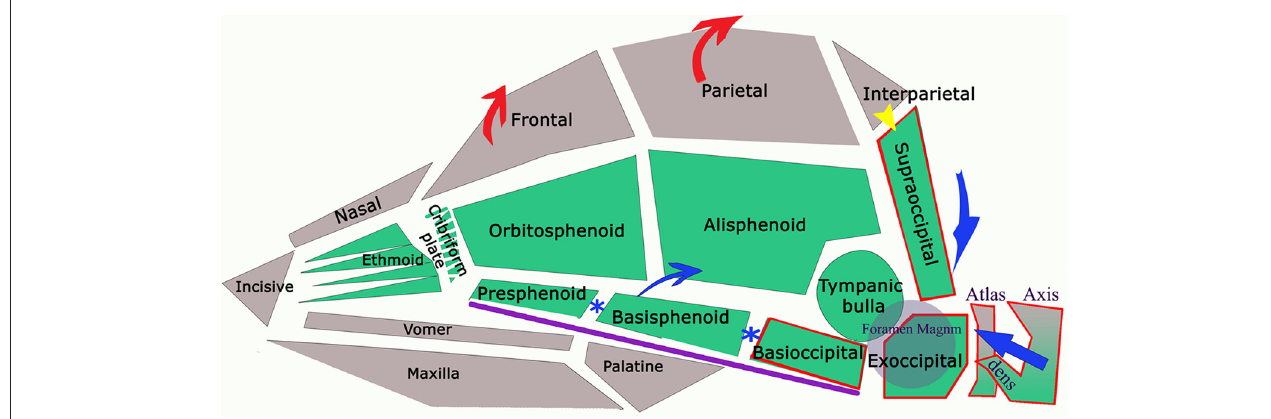
FIGURE 5 | Diagram of the bones referred in text (lower jaw not illustrated) with arrows to indicate anatomical changes in dogs with CM. The green colored bones are endochondral in origin (neurocranium of skull and notochord in axial skeleton). Calvaria and facial bones have membranous ossification (viscerocranium). Sclerotomal occipital region bones (i.e., craniocervical junction) indicated by red border. Purple line indicates the skull base. In dog and man, interparietal and supraoccipital fuse (yellow arrow). The reduced volume of the caudal fossa in CM is indicated by the blue arrows: reduction of the supraoccipital and dorsal displacement of atlas and axis; premature closure of synchondroses of bones in skull base (blue*) shortening the skull base and compensatory increase in height of the parietal bone and frontal bone (red